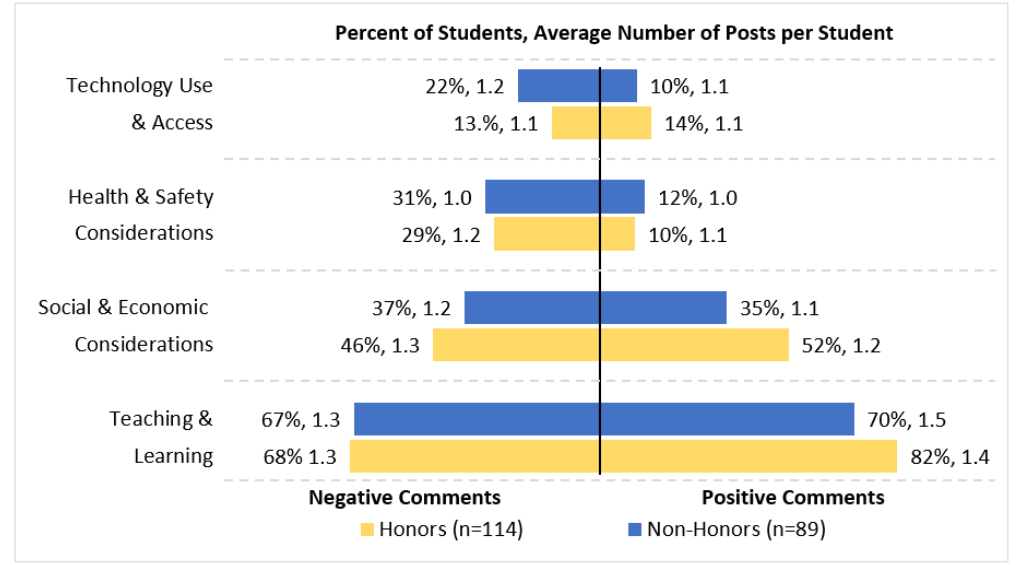
Figure 6: Percentages and posts made by honors and non-honors students in each of the four major themes: technology use and access, health and safety considerations, social and economic considerations, and teaching and